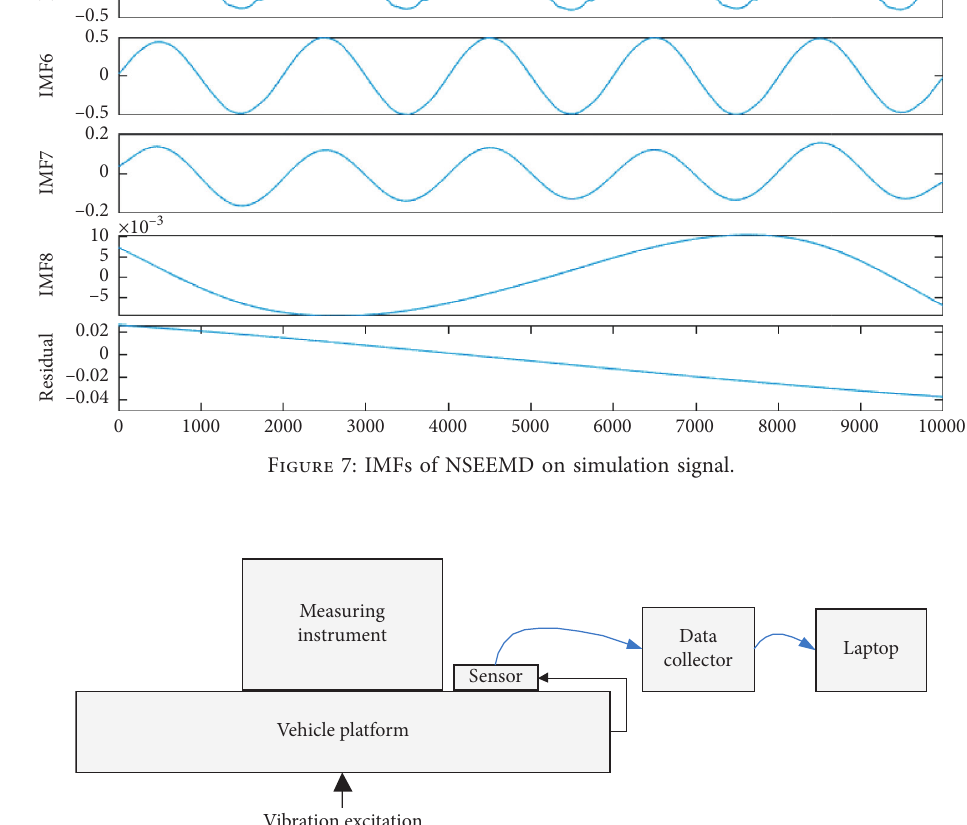
Figure 8: Layout of vibration information